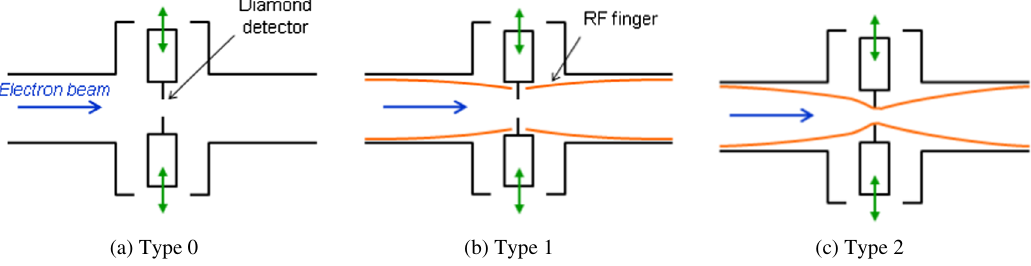
FIG. 2. Configurations of the rf fingers: (a) type 0, without fingers; (b) type 1, with fingers (the active areas of the detectors are not covered); (c) type 2, with fingers